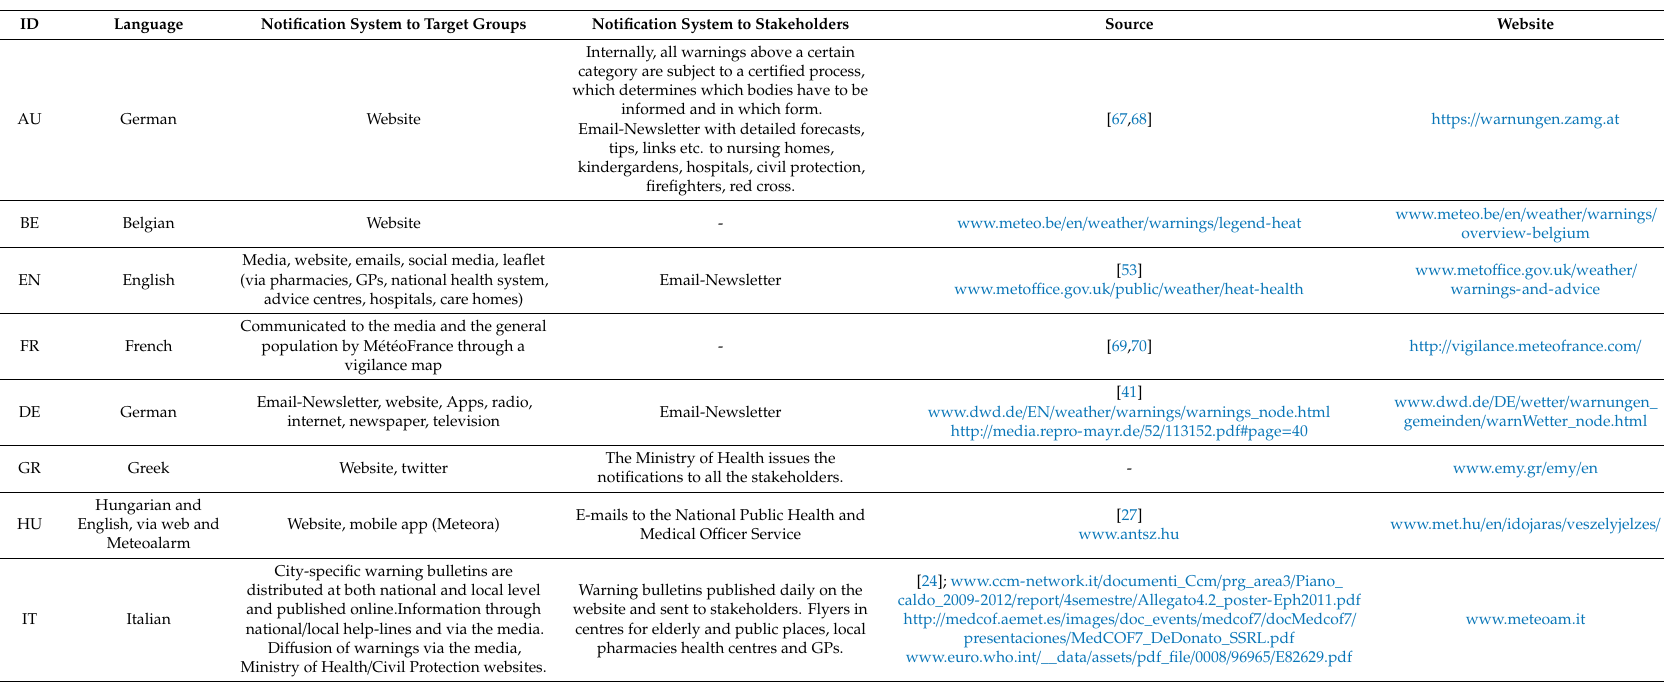
Table 4. Communication strategies of the heat warnings.